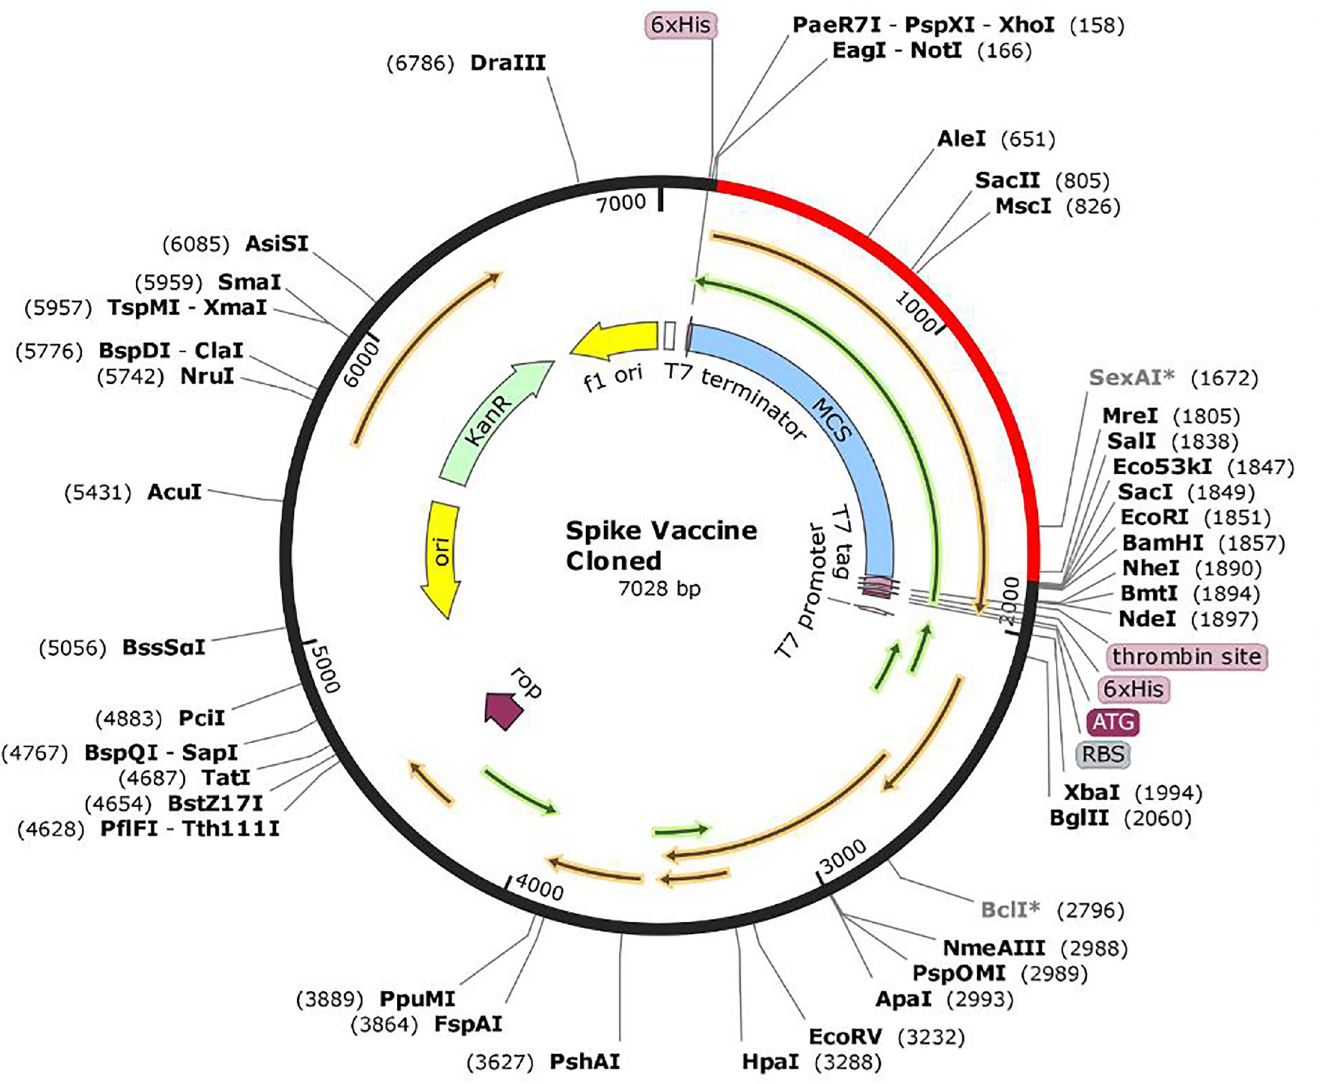
Fig 7. In silico cloning of the final vaccine construct into pET28a (+) expression vector where the red part indicates the coding gene for the vaccine surrounded between EagI-NotI (166) and SAlI (1838) while the vector backbone has shown in a black circle. MCS represents the multiple cloning